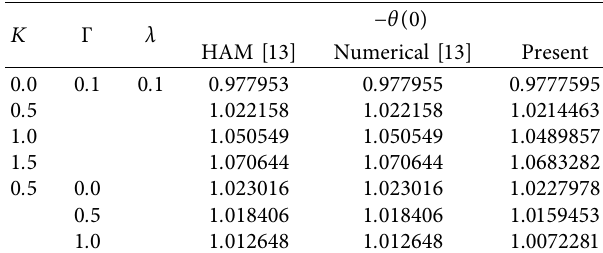
Table 2: The local Nusselt number for different values of K and Γ